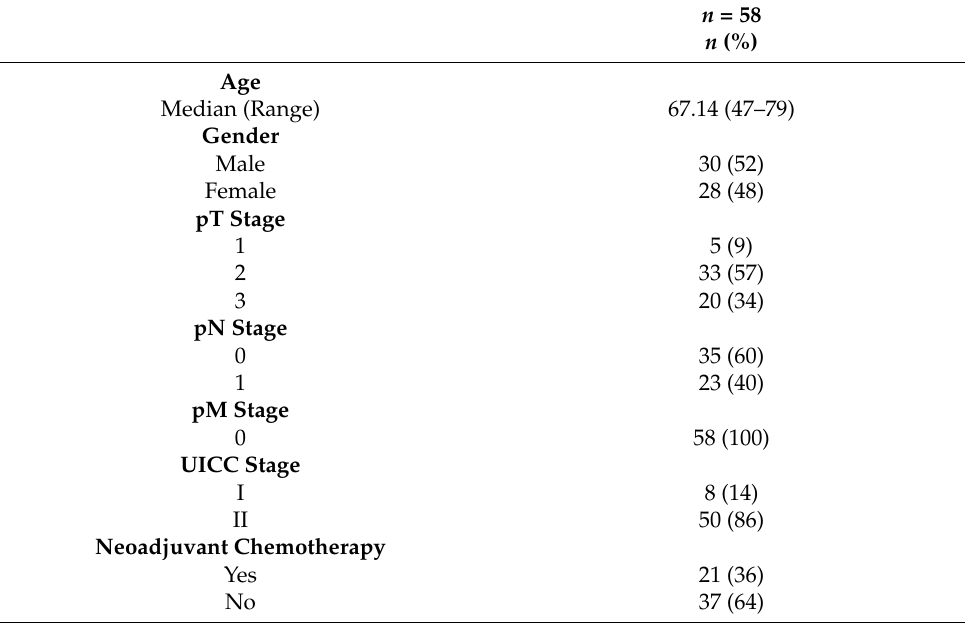
Table 1. Clinicopathologic characteristics of pancreatic ductal adenocarcinoma (PDAC)